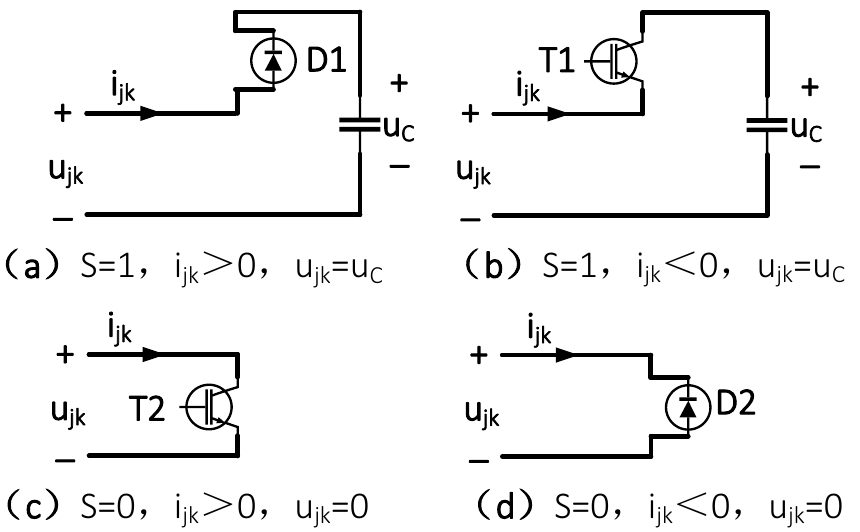
Figure 3. Working principle of an MMC half-bridge submodule. ( a ) Working condition in S = 1, i jk > 0. ( b ) Working condition in S = 1, i jk < 0. ( c ) Working condition in S = 0, i jk > 0. ( d ) Working condi- tion in S = 0, i jk < 0.